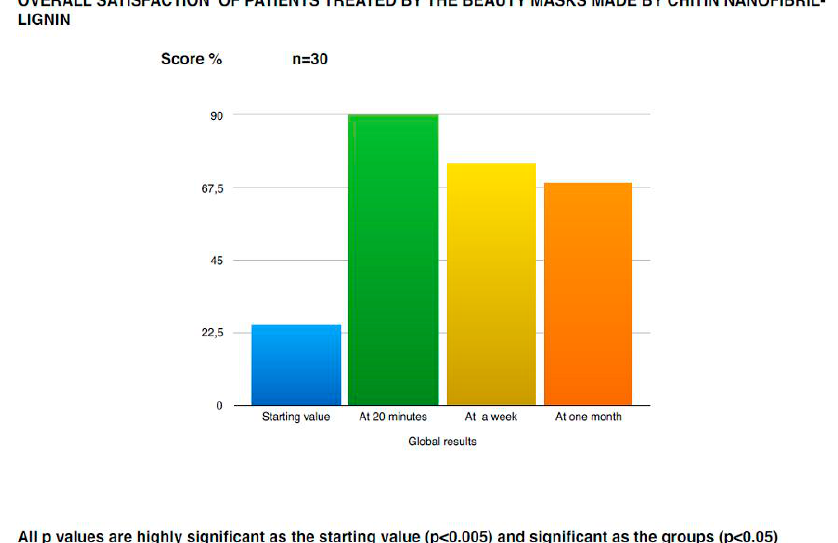
Figure 13. Patient evaluation of the mask’s rejuvenation effectiveness on their own skin.